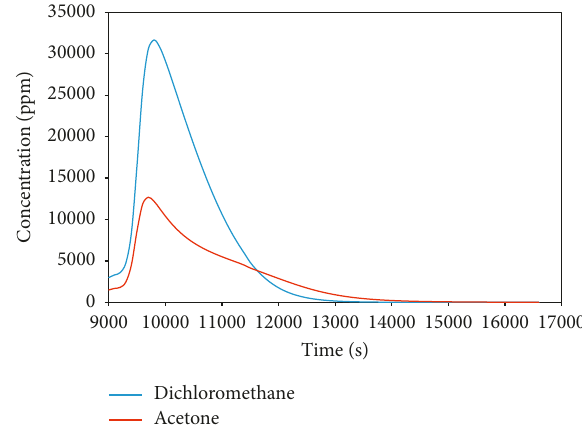
Figure 17: Concentration of dichloromethane and acetone profiles at the column outlet during the heating